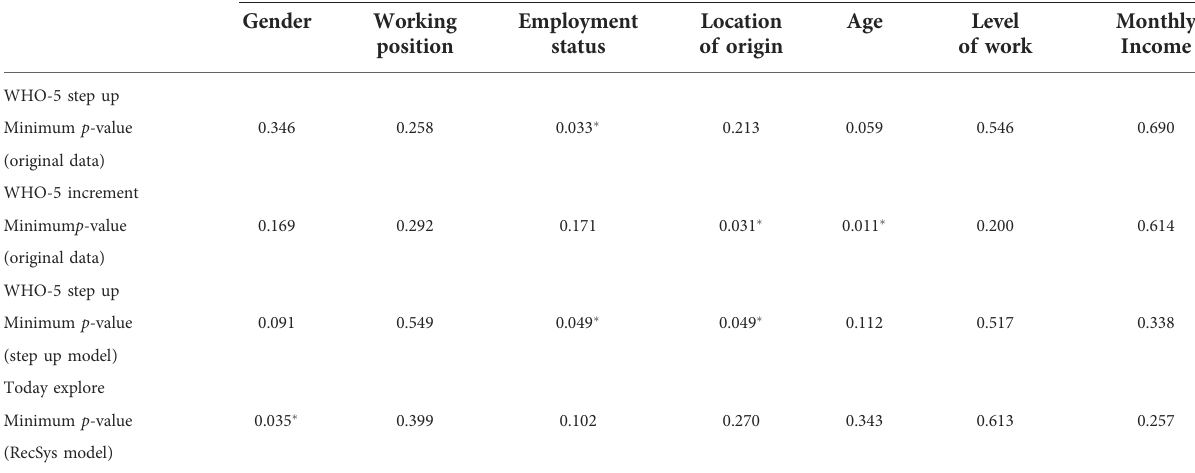
TABLE 5 Minimum p -values for Fisher ’ s exact test on contingency tables involving a sensitive attribute and the following targets: WHO-5 step ups in the original data, WHO-5 increments in the original data, and WHO-5 step up events as predicted by the step up model.